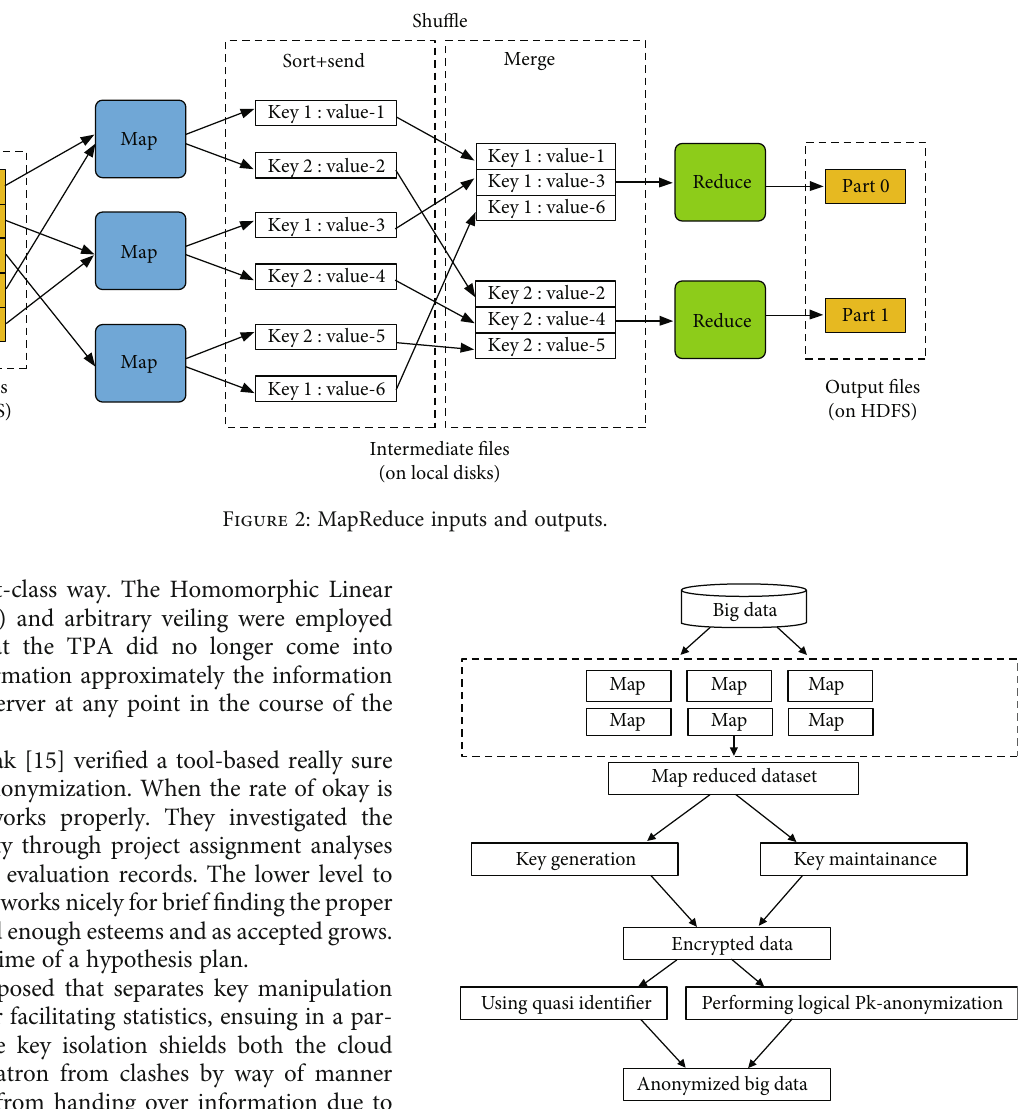
Figure 3: Block diagram of Logical